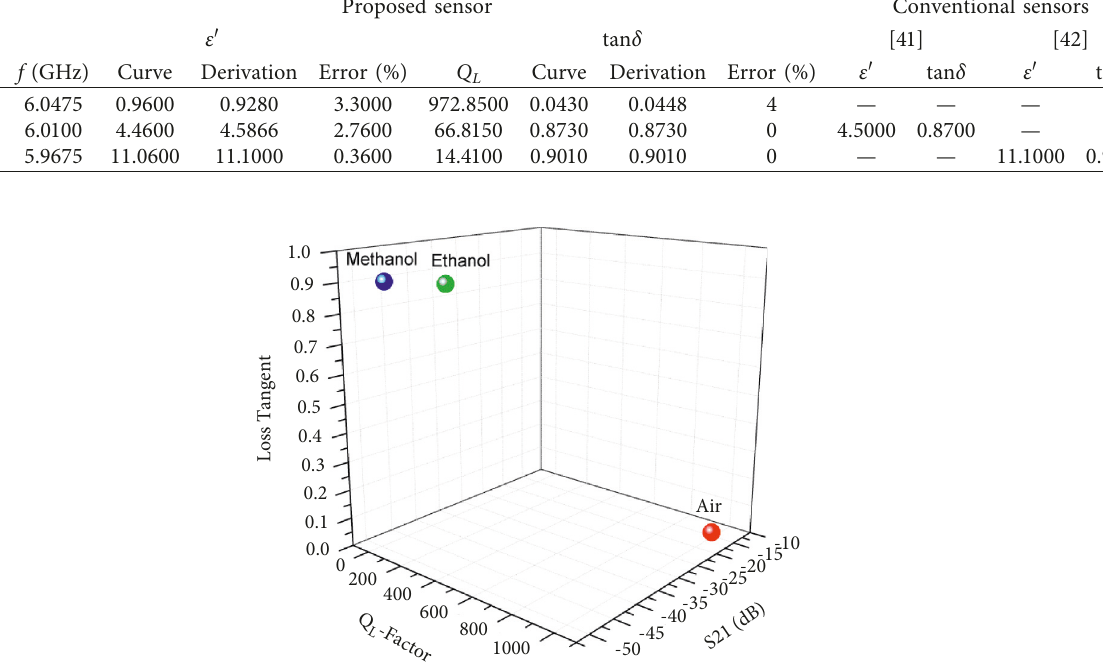
Figure 13: Relationship between the loss tangent, Q Table 4: Comparison of the finalised sensor with the current methods for liquid characterisation.